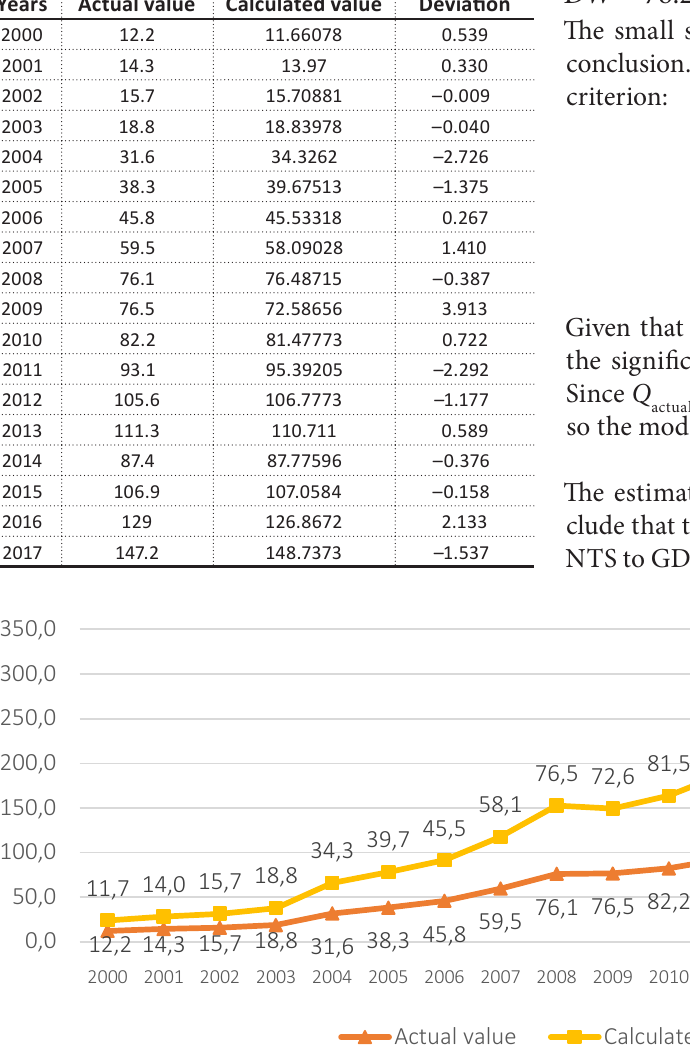
Figure 3. The actual and model-based dynamics of change in the dependent feature